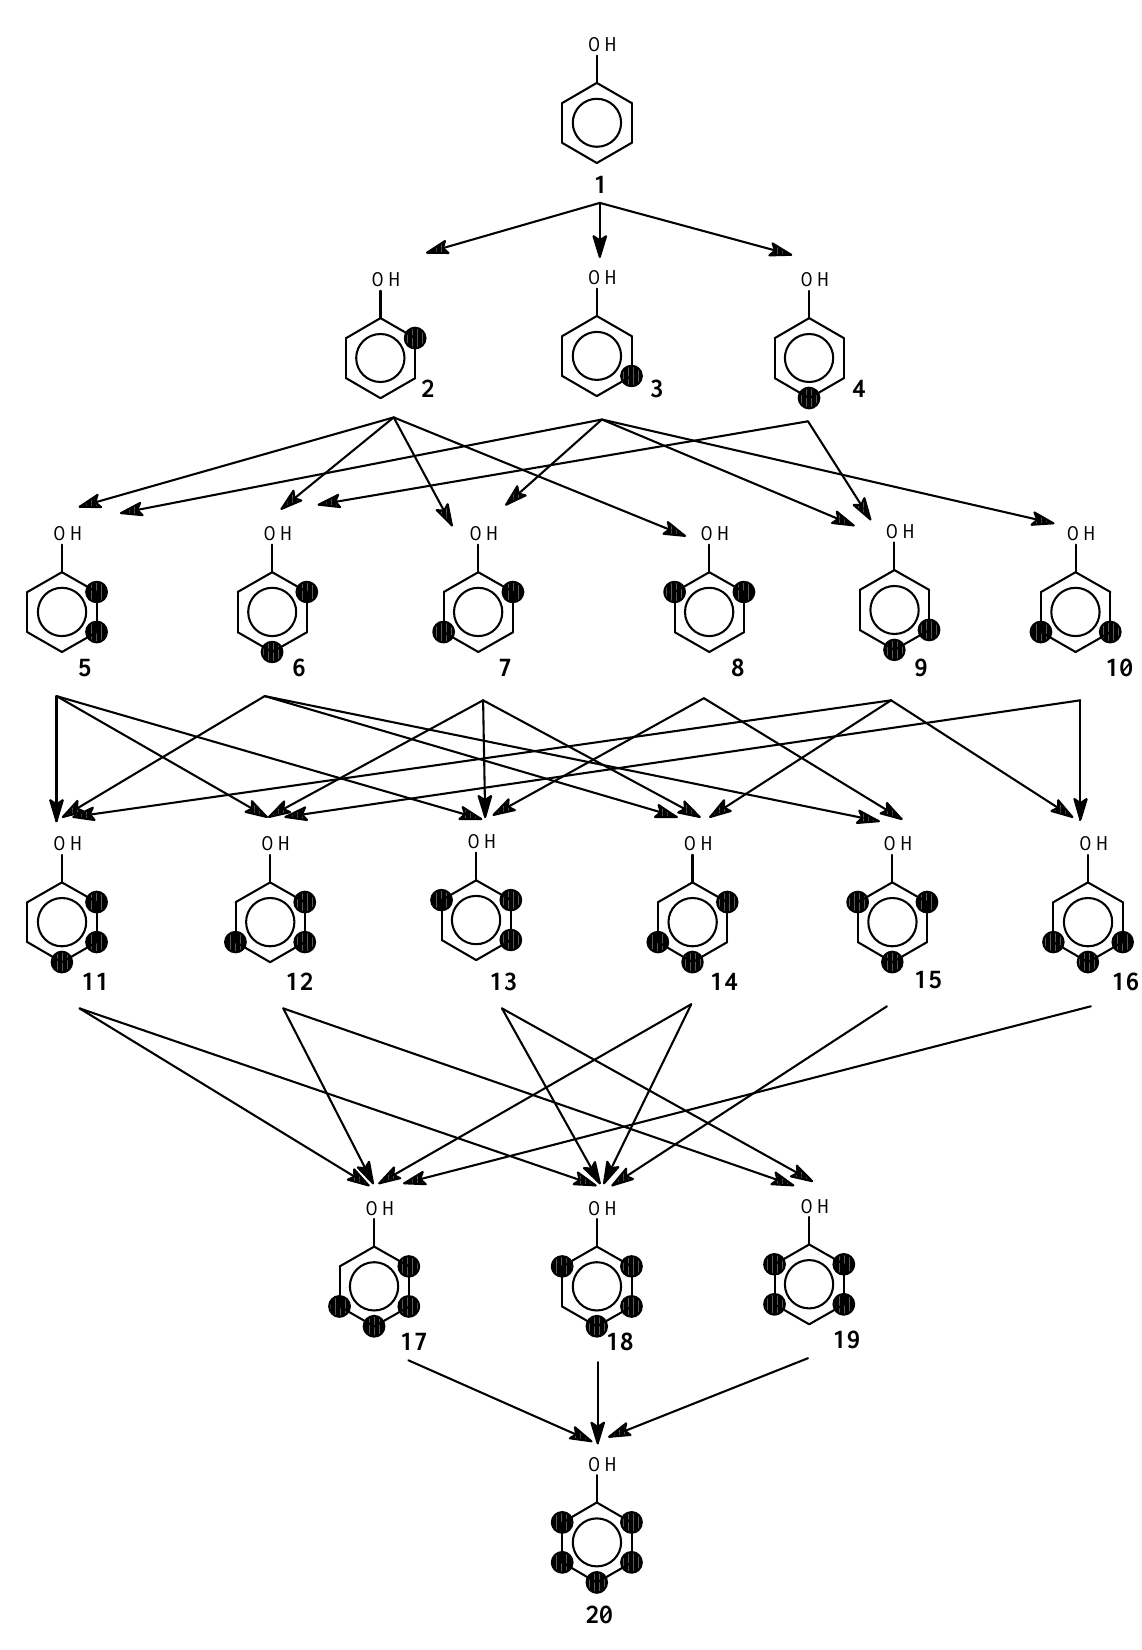
Figure 1. The posetic phenol super-structural substitution–reaction network. The black enlarged dots indicate the sites on which an aromatic H atom of phenol has been replaced by a Cl